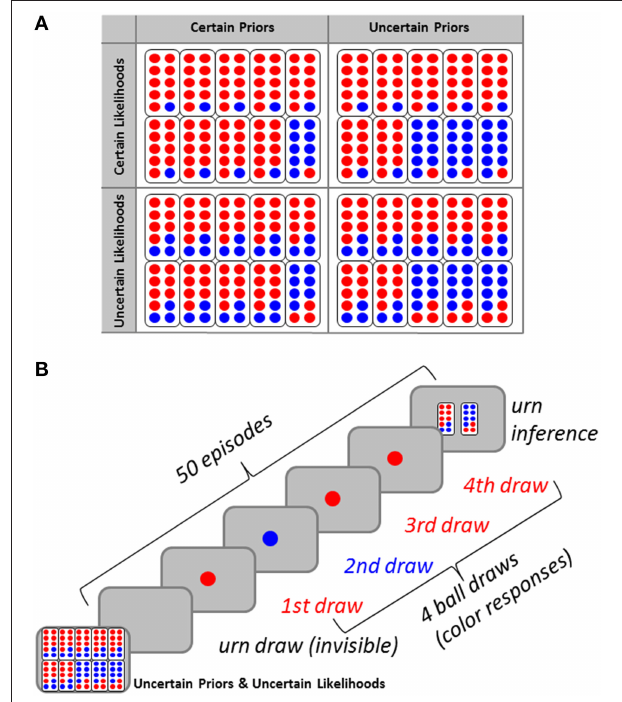
FIGURE 1 | (A) Participants were graphically informed about the four probability conditions of the urn-ball task [certain priors ( P = 0.9, P = 0.1), uncertain priors ( P = 0.7, P = 0.3), certain likelihoods ( P = 0.9, P = 0.1), uncertain likelihoods ( P = 0.7, P = 0.3)]. (B) Each of the four probability conditions (here, the uncertain priors and uncertain likelihoods condition serves as an example) comprised 50 consecutive episodes of sampling that consisted of the invisible drawing of one urn, the visible drawing of a sample of four balls from that urn (sequential drawing with replacement). Participants indicated which urn they considered more likely, given the number of blue balls drawn (zero to four), and based on the condition (prior probability and likelihood